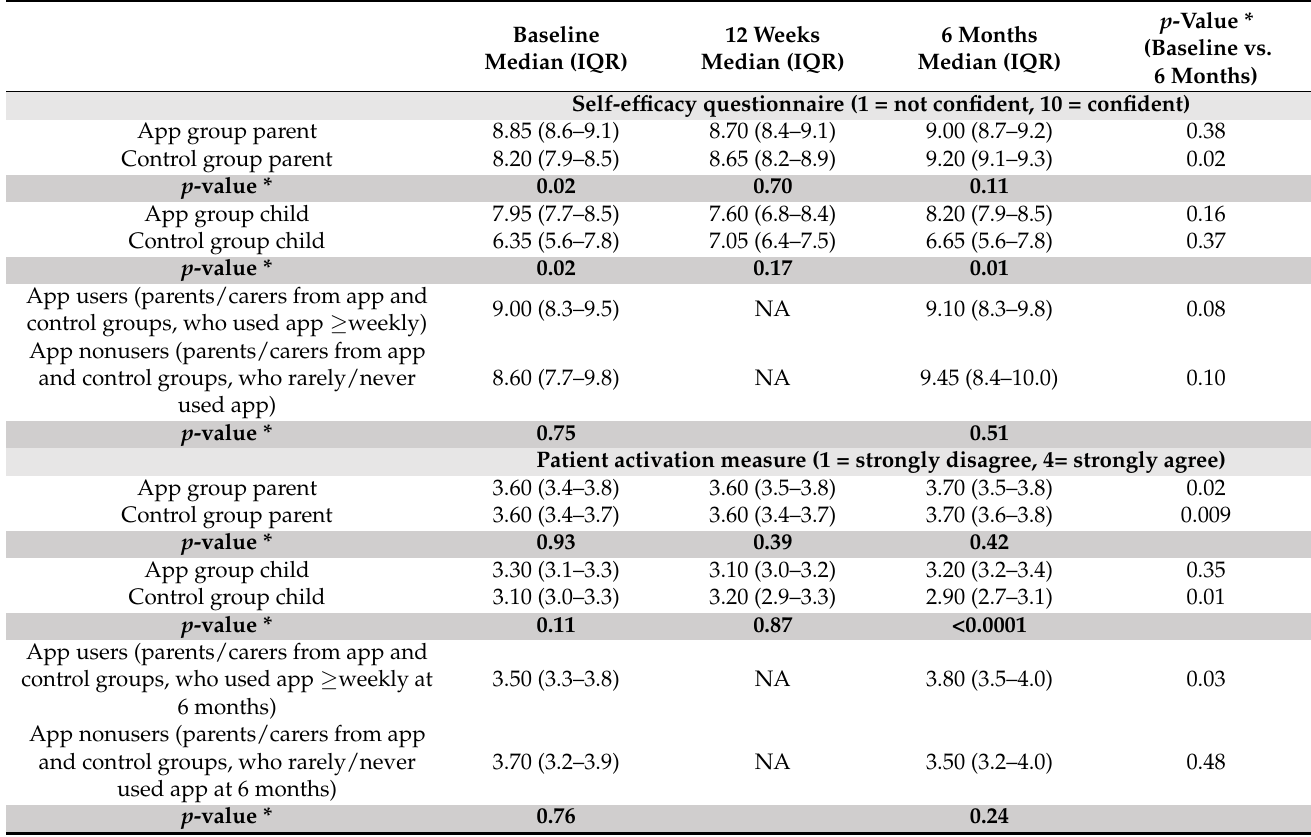
Table 5. Self-efficacy and patient activation measure mean scores for app and control groups at baseline, 12 weeks, and 6 months.